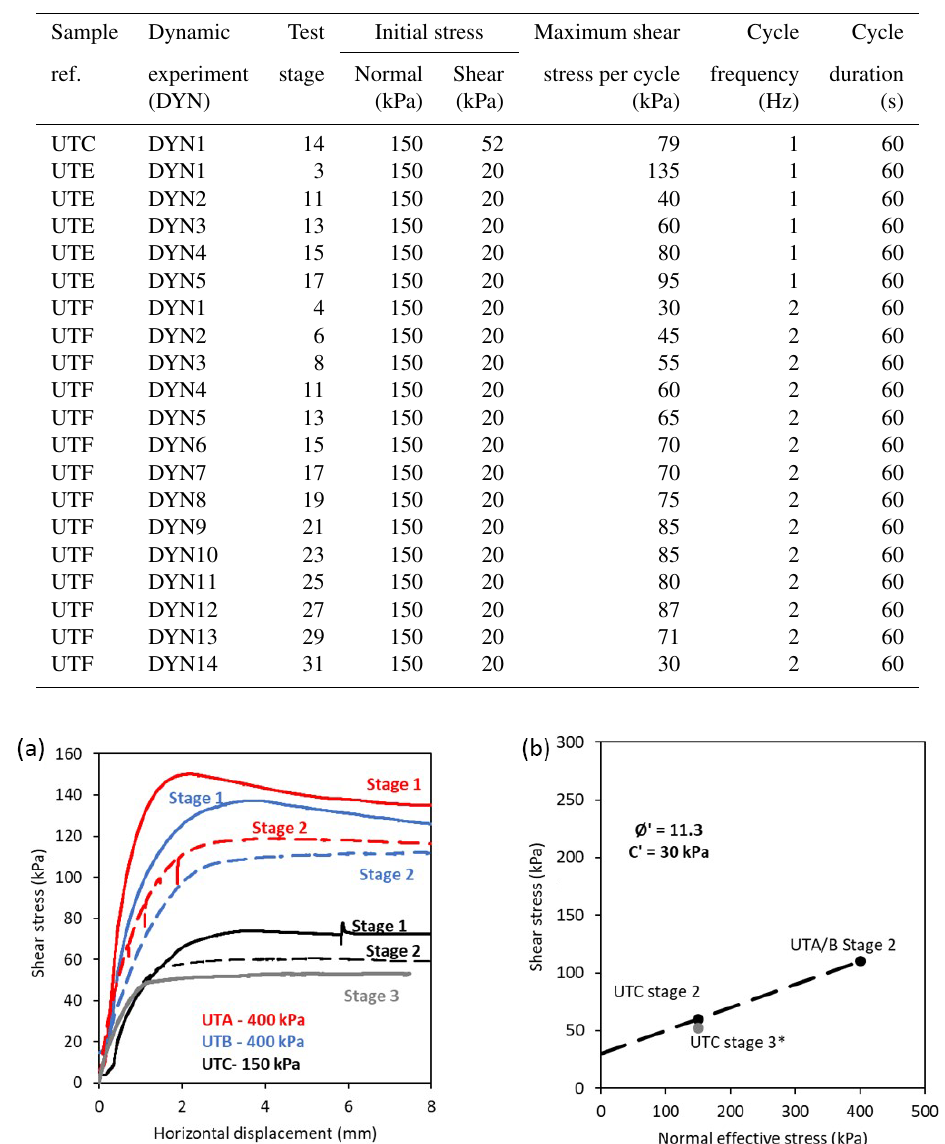
Table 3. Summary of dynamic shear experiment parameters.